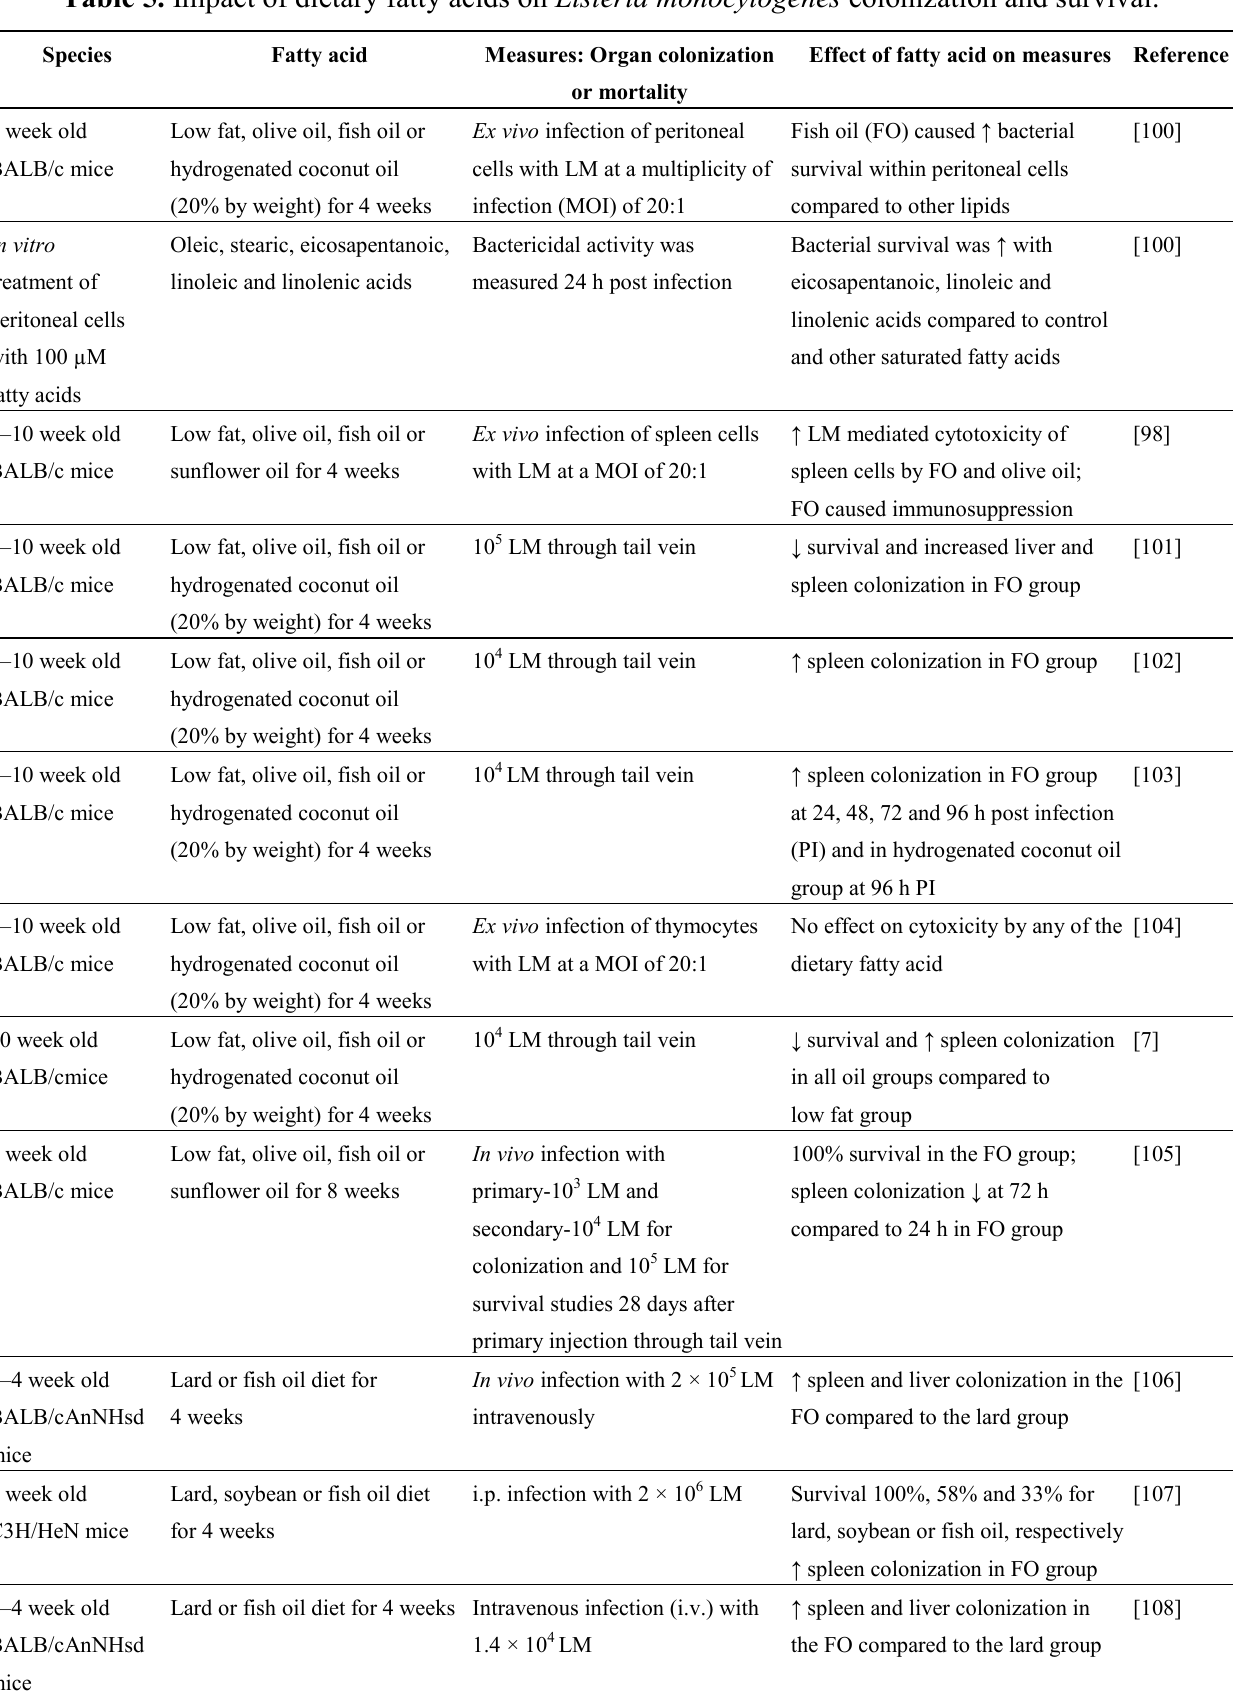
Table 5. Impact of dietary fatty acids on Listeria monocytogenes colonization and survival. Species Fatty acid Measures: Organ colonization Effect of fatty acid on measures or mortality